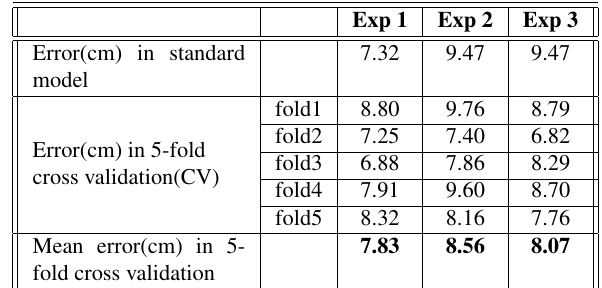
Figure 5. Contd. qualitative evaluation of test images.